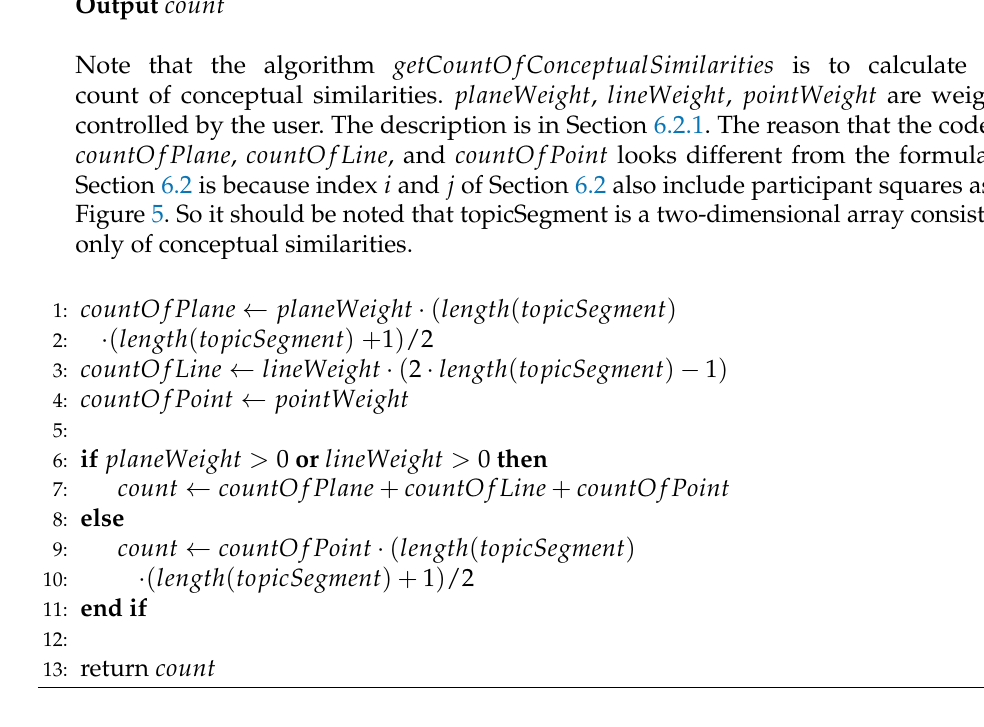
Algorithm A6 getCountO f ConceptualSimilarities . Input